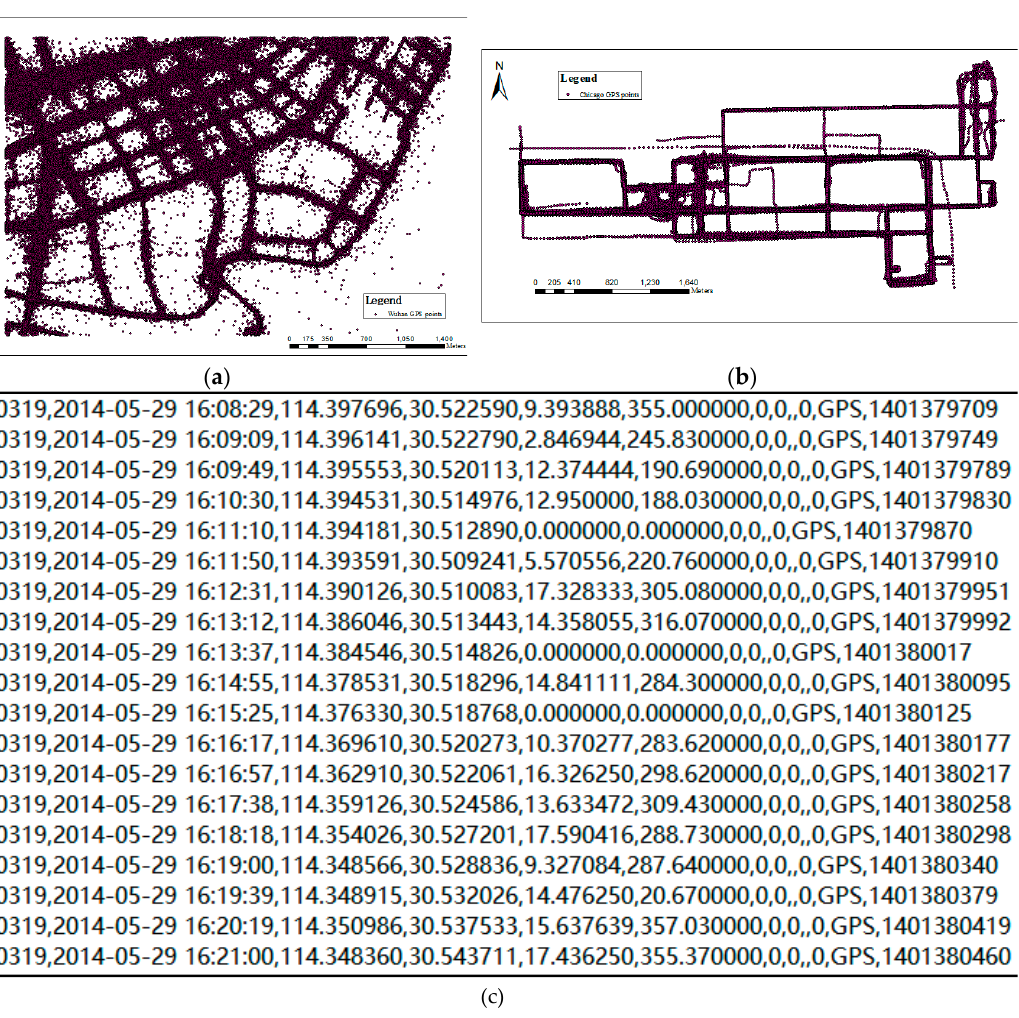
Figure 15. Trajectory datasets: ( a ) GPS trajectory dataset for Wuhan; ( b ) GPS trajectory dataset for Chicago; ( c ) trajectory text data example for Wuhan.